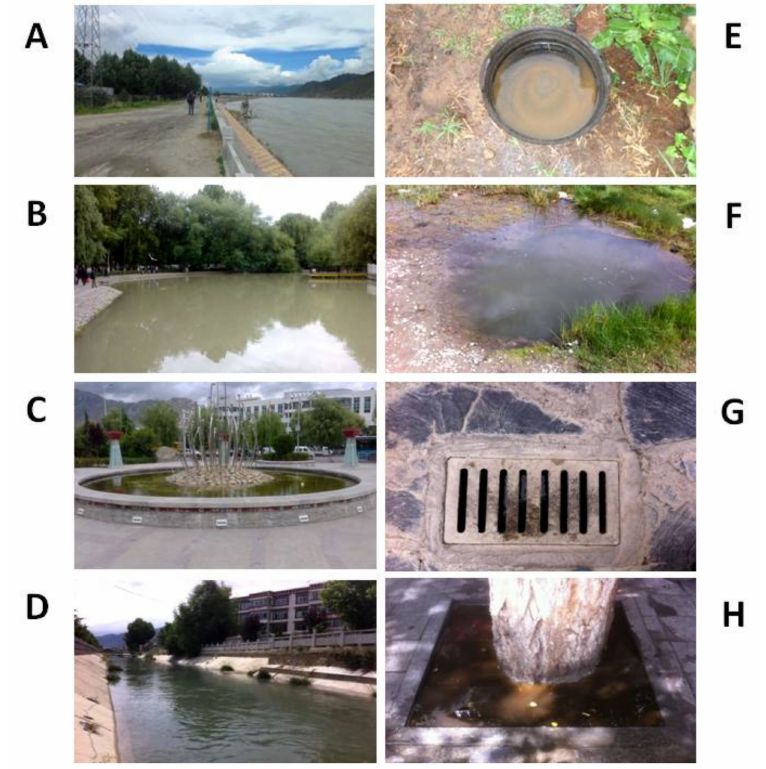
Figure 2. Representative water bodies in Lhasa City, Tibet, P. R. China. ( A ) River fringe; ( B ) Pond ( ≥ 50 m 2 ); ( C ) Puddle ( < 50 m 2 ); ( D ) Irrigation / drainage ditch; ( E ) Containers; ( F ) Temporary ground pool; ( G ) Sewer / tube well; ( H )